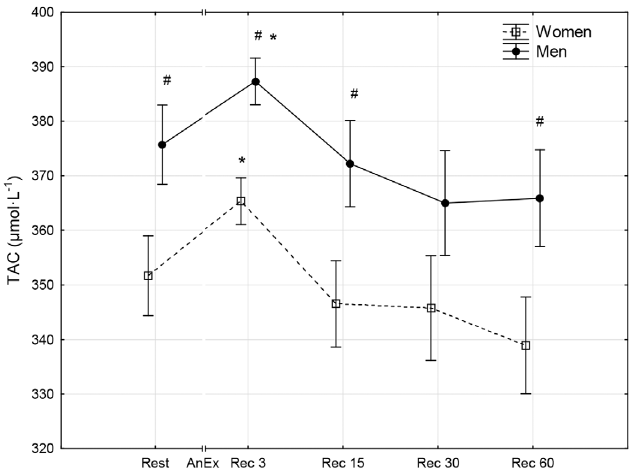
Fig 2. The level of total antioxidative capacity of blood plasma (TAC) prior to (Rest) and 3 minutes (Rec 3), 15 minutes (Rec 15), 30 minutes (Rec 30) and 60 minutes (Rec 60) after anaerobic exercise (AnEx). Data are given as mean ± standard error; p < 0.05 statistically significant differences * between results obtained after anaerobic exercise (AnEx) and initial results (Rest); # between results obtained by men and